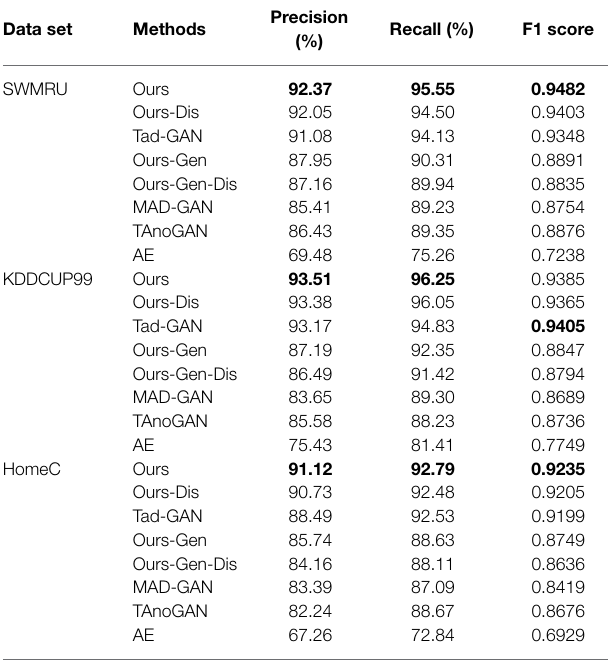
The bold values in Table 3 are the highest values of each experimental metric for each data